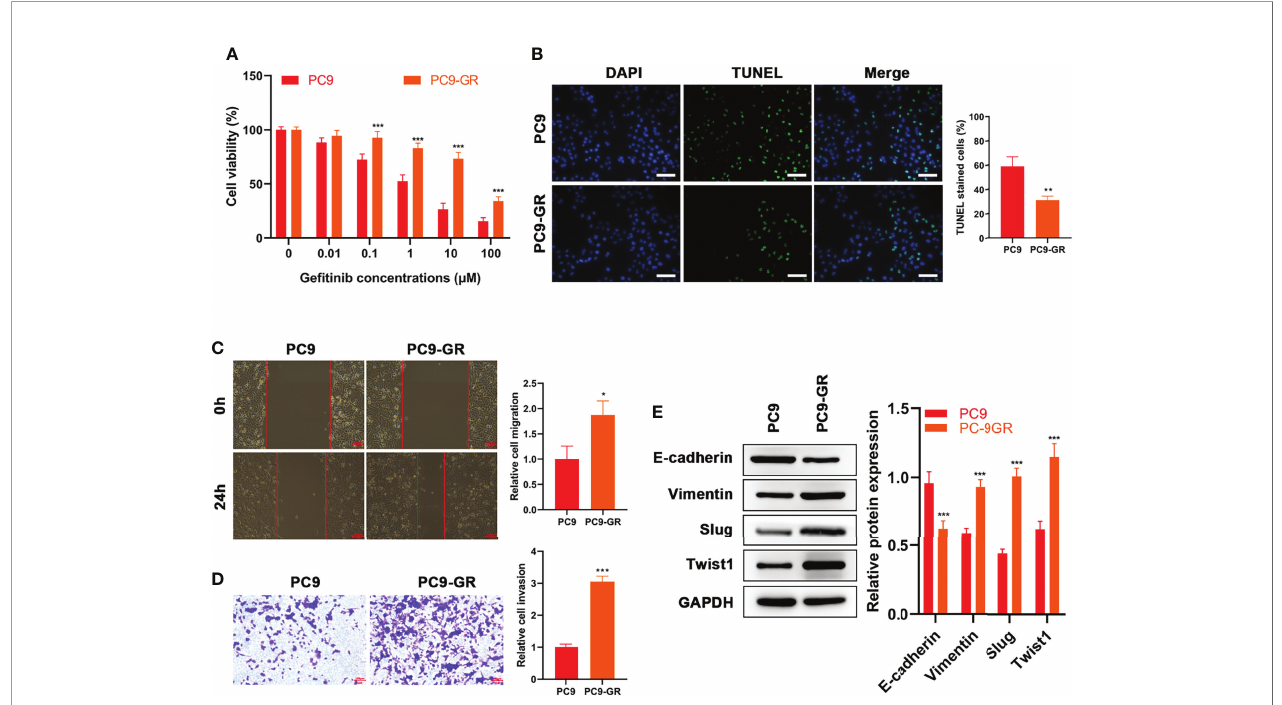
FIGURE 1 | EMT Occurred in Ge fi tinib ‐ Resistant Cells. (A) CCK8 results of PC9 and PC9-GR cells at different concentrations of ge fi tinib treatment (B) TUNEL results, (C) wound healing assay results and (D) Transwell assay of PC9 and PC9-GR cells at 1 m M of ge fi tinib (E) Expressions of EMT-related proteins (E-cadherin, Vimentin, Slug and Twist1) in the two cell lines at 1 m M of ge fi tinib detected by WB results. Scale bar = 100 m m. *p<0.05, **p<0.01,